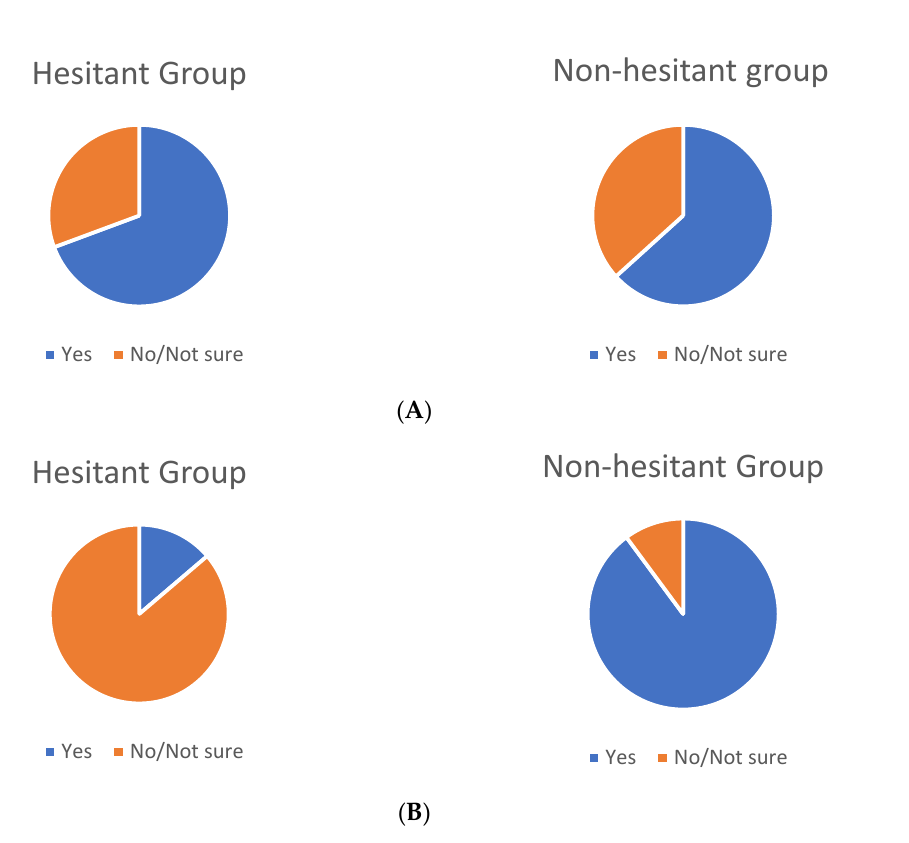
Figure 2. ( A ) Need for booster vaccine doses against new variants —“ Are you worried that the current vaccine might not be effective against new strains , and you might require a booster dose or repeat vaccination?” ( B ) Acceptance of potential yearly booster vaccine to maintain immunity —“Would you be willing to take the vaccine/booster dose every year if required for sustained immunity?” .